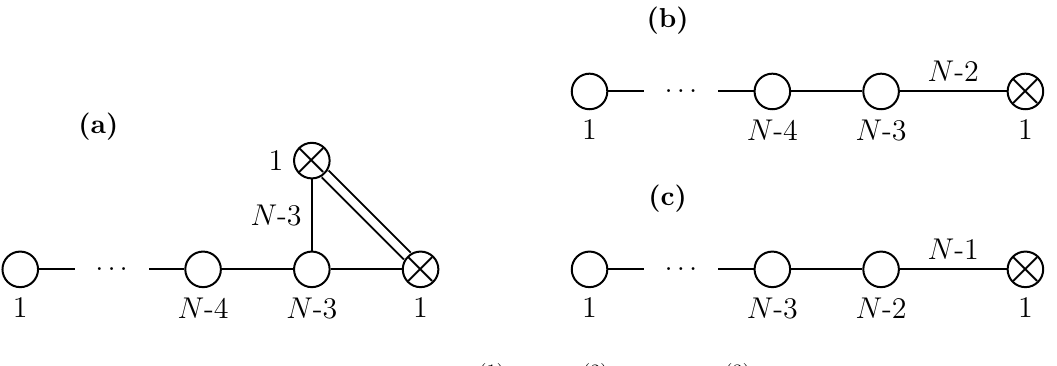
Figure 29 . MQs for (a) B (1)